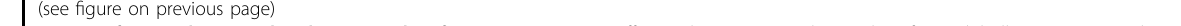
Fig. 3 Tnfaip3 is downregulated in microglia after nerve injury. a Differential expression volcano plot of pseudobulk scRNA-Seq analysis. The S-phase microglia from day 1 after nerve injury displayed different gene expression pro fi le from that of the S-phase microglia 2 days after nerve injury in Cx3cr1-creER-yfp/ + ; + / + animals. b , c qRT-PCR of FACS-sorted microglia from lumbar spinal cord of Cx3cr1-creER-yfp/ + ; + / + animals ( b ) and of RiboTag enriched microglia mRNA from lumbar spinal cord ( c ). Tnfaip3 was downregulated in the microglia of ipsilateral lumbar cord 1 and 2 days after nerve injury. d Quanti fi cation of proliferating Ki67 ( + ) microglia by fl ow cytometry. Naive uninjured Cx3cr1-creER-yfp/ + ; Tnfaip3 fl / fl A20 cKO animals had signi fi cantly more baseline microglia proliferation than those of naive control Cx3cr1-creER-yfp/ + ; + / + animals. e scRNA-Seq PCA scatter plot of naive Cx3cr1-creER-yfp/ + ; Tnfaip3 fl / fl A20 cKO microglia. The distributions of G1, S, and G2/M phase cells were similar to that of Cx3cr1-creER- yfp/ + ; + / + control animals 3 days after nerve injury as shown in Fig. 1d. f – h scRNA-Seq PCA scatter plot of Cx3cr1-creER-yfp/ + ; Tnfaip3 fl / fl A20 cKO microglia 1 day ( f ), 2 days ( g ), and 3 days ( h ) after nerve injury. The distributions of G1, S, and G2/M-phase cells were similar to that of naive Cx3cr1- creER-yfp/ + ; Tnfaip3 fl / fl A20 cKO animals ( e ). Analyses are two-way ANOVA with Sidak ’ s multiple comparison test ( b , c ) and unpaired two-tailed t -test ( d ), n = 4 – 6, means ± SEM, * P < 0.05, ** P < 0.01, *** P < 0.001, and **** P < 0.0001.